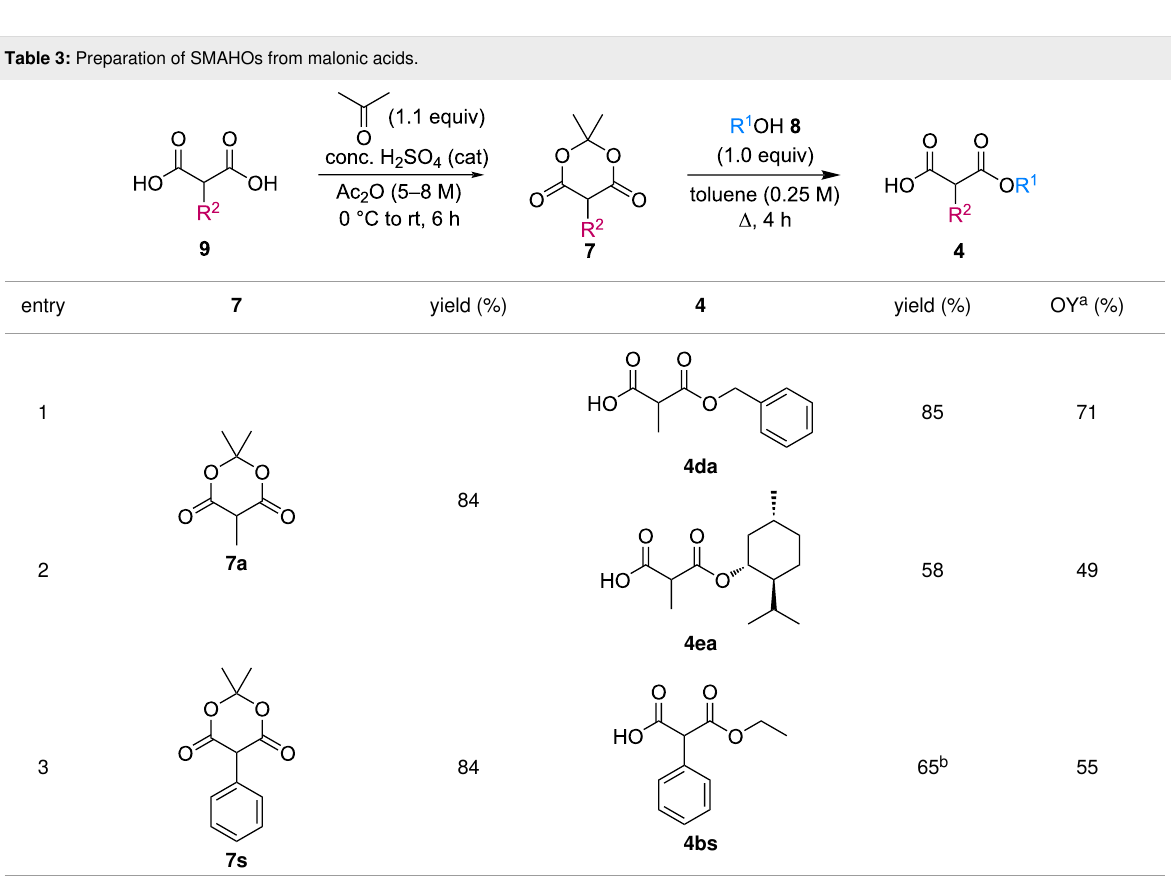
Table 3: Preparation of SMAHOs from malonic